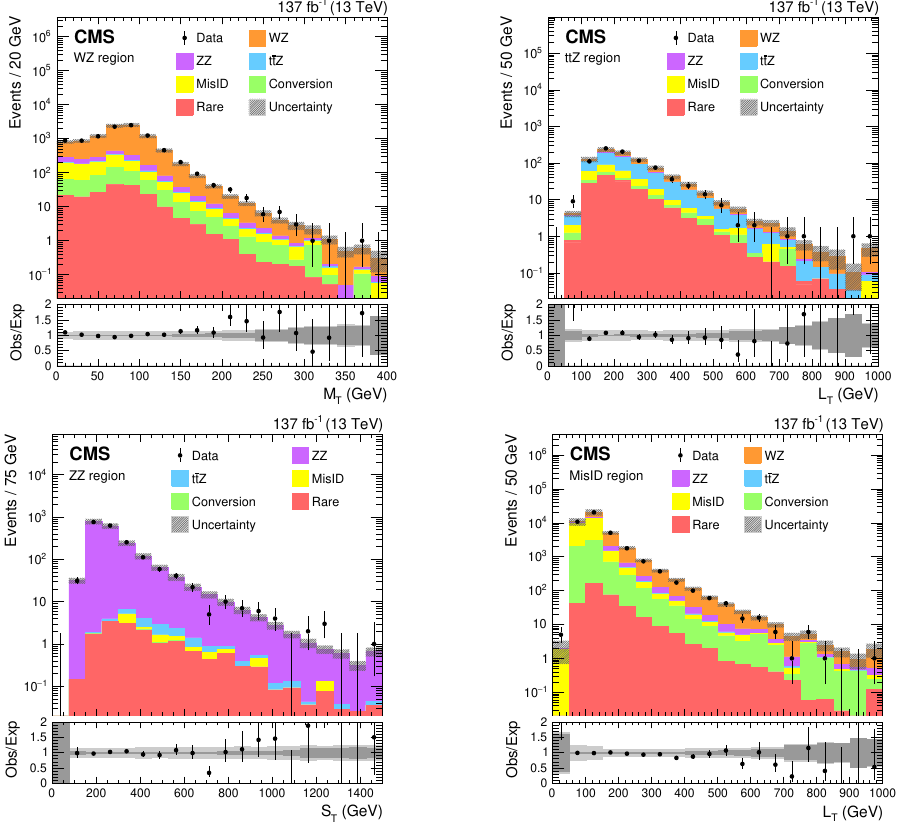
Figure 2 . The M distribution in the WZ-enriched control region (upper left), the L distribution T T in the ttZ-enriched control region (upper right), the S distribution in the ZZ-enriched control T region (lower left), and the L distribution in the misidenti(cid:12)ed-lepton (Z+jets) enriched control T region (lower right). The lower panels show the ratio of observed to expected events. The hatched gray bands in the upper panels and the light gray bands in the lower panels represent the total (systematic and statistical) uncertainty of the backgrounds in each bin, whereas the dark gray bands in the lower panels represent only the statistical uncertainty of the backgrounds. The rightmost bins contain the over(cid:13)ow events in each